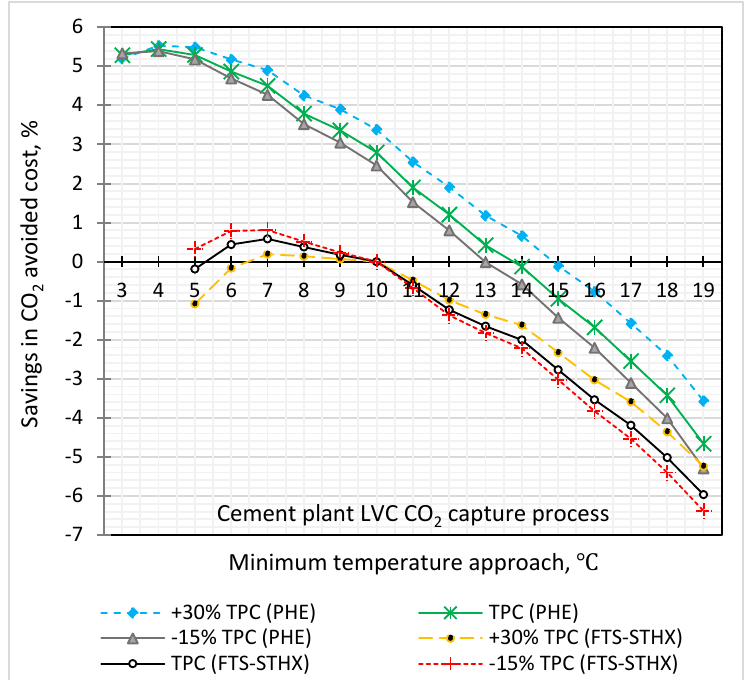
Figure 22. Sensitivity analysis of TPC on the energy and heat exchanger costs trade–off analyses at different ∆𝑇 (cid:3040)(cid:3036)(cid:3041) for different heat exchanger types in a standard CO 2 capture from cement flue gas. 3.13. Comparison of Optimum ∆𝑇 (cid:3040)(cid:3036)(cid:3041) Results with Literature